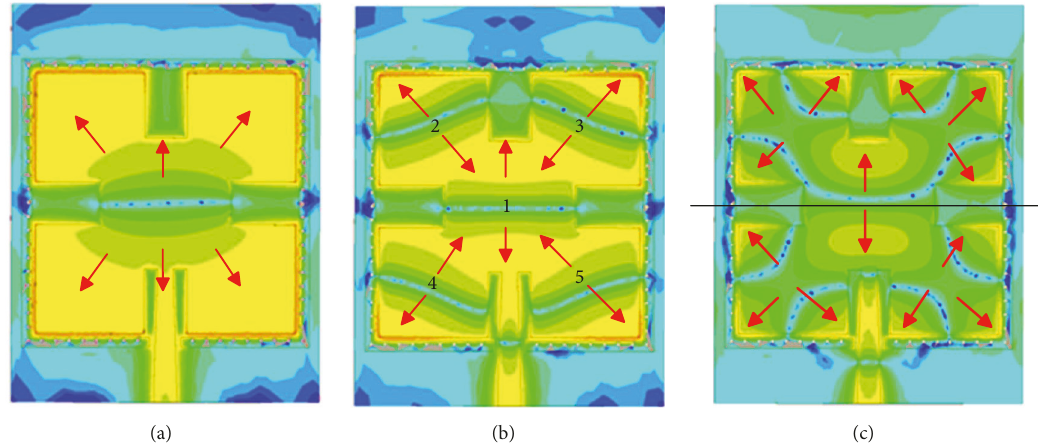
Figure 7: Electric field distribution of other modes: (a) first mode; (b) fourth mode; (c) fifth mode.